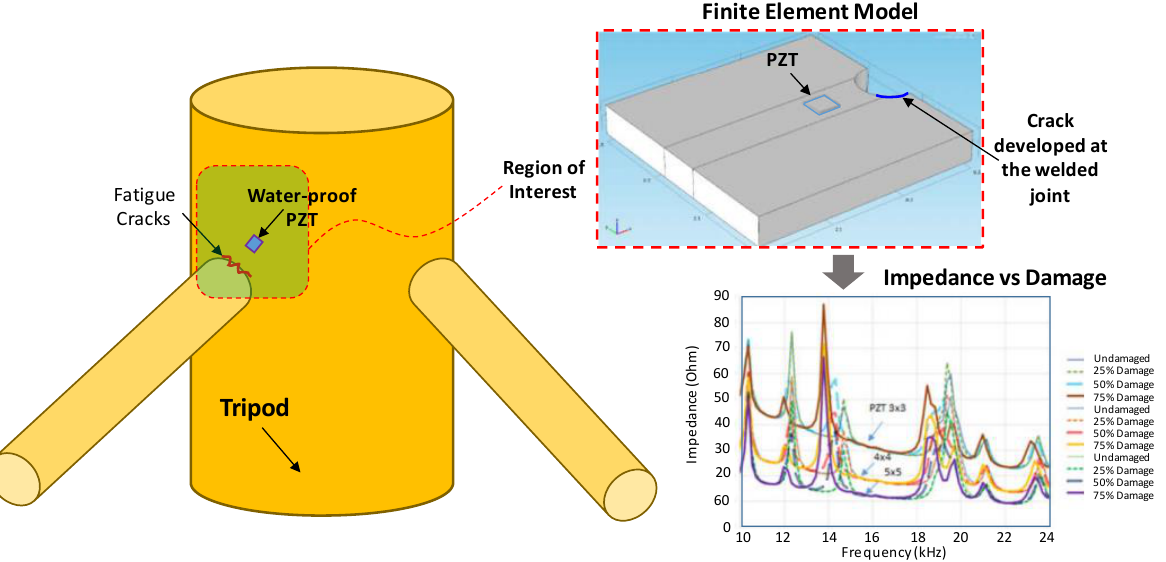
Figure 15. Impedance-based fatigue crack monitoring of the upper central joint of the offshore wind turbine tripod [106] .